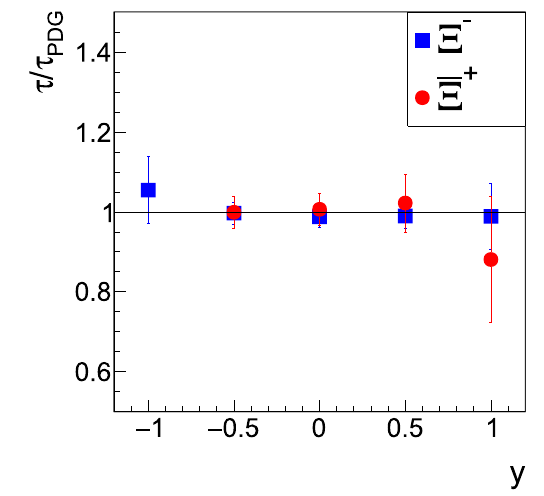
Fig. 3 Measured lifetime ratio τ/τ PDG for (cid:2) − (blue squares) and (cid:2) + (red circles) as a function of center of mass rapidity. Only statistical uncertainties are